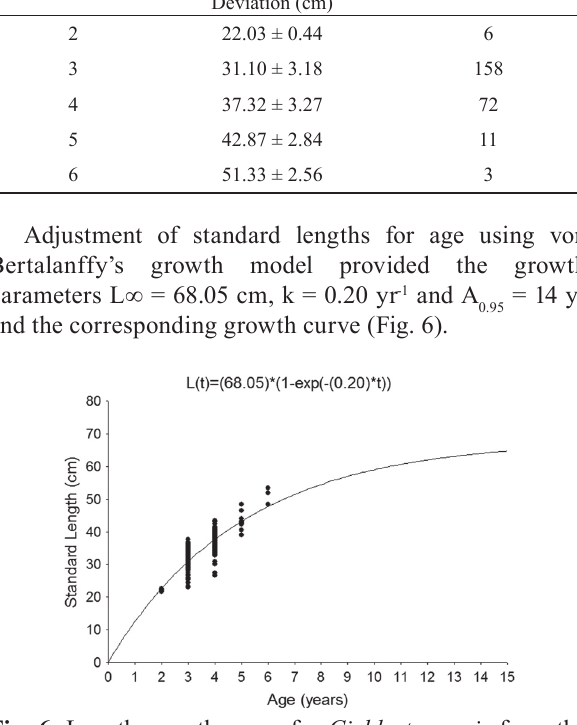
Fig. 6. Length growth curve for Cichla temensis from the middle rio